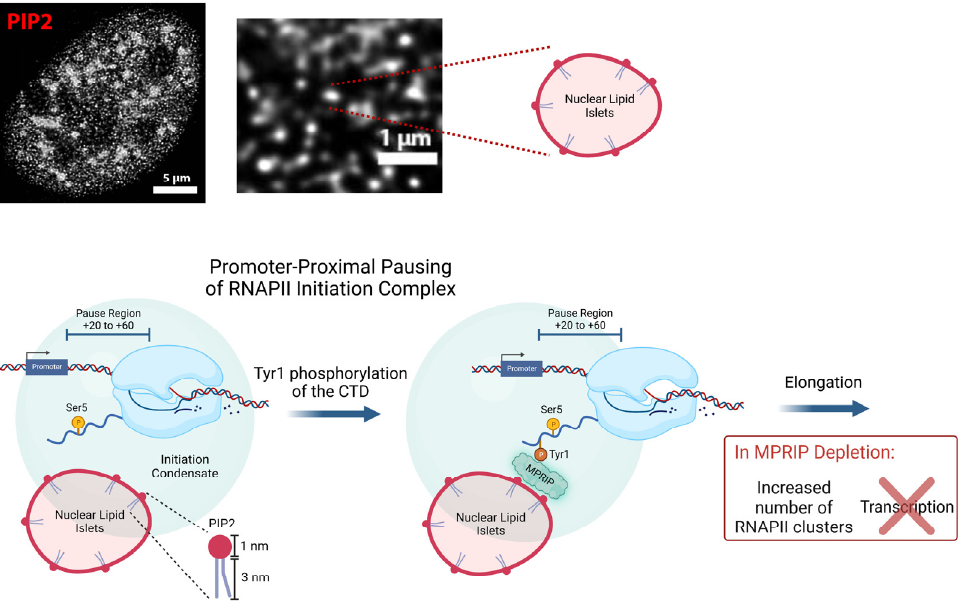
Figure 6. Model depicting proposed mechanism for the MPRIP-mediated PIP2 association with Tyr1-phosphorylated-RNAPII complex facilitating the release of RNAPII from the promoter- proximal pausing . The Ser5-phosphorylated RNAPII pauses at the promoter-proximal region (+20 to +60 bp). PIP2-containing nuclear lipid islets (NLIs) associate with the initiation condensate [18–21]. Following the Tyr1 phosphorylation of the Rpb1 CTD, MPRIP mediates the interaction between the RNAPII complex and NLIs. By regulating the association of the RNAPII complex with PIP2, MPRIP affects the release of the RNAPII complex from the initiation condensate. In case of MPRIP depletion, there is an increased association between Ser5P-CTD and PIP2. We suggest that the change in this association causes a defect in promoter-proximal pause and prevents RNAPII being released from the initiation condensate. As a result, the transcription is downregulated and the number of RNAPII foci is increased.